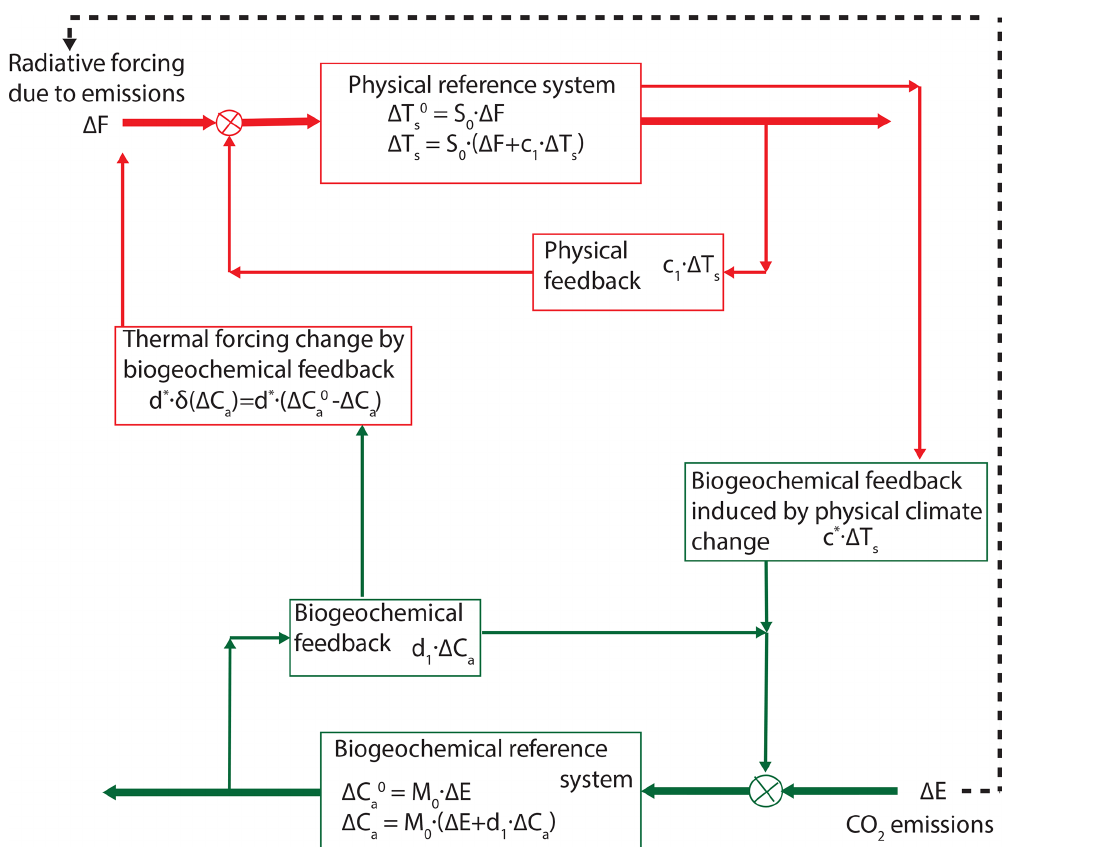
Figure 3. The physical (red) and biogeochemical carbon cycle systems (green) within the Earth system are governed by their respective phys- ical and biogeochemical feedback loops and through couplings between the physical and biogeochemical worlds. The coupling of physics to biogeochemistry is induced by the total response of physical climate state variables to the imposed forcing change (represented by (cid:49)T s ), while the coupling of biogeochemistry to physics is induced by the greenhouse gas concentration change δ ( (cid:49)C a ) caused by biogeochemical feedbacks. The change in greenhouse gas concentration (cid:49)C a in the presence of biogeochemical feedback (e.g. the fertilization of plants through higher CO 2 levels and respective increased growth) is different to a case without this feedback. M 0 is the climate sensitivity pa- rameter for the reaction of the biogeochemical system due to a biogeochemical forcing change. The symbols are explained in more detail in Sects. 2.1 and 2.2. The dashed black arrow illustrates that the CO 2 emissions are initially the same for the chemical and the radiative